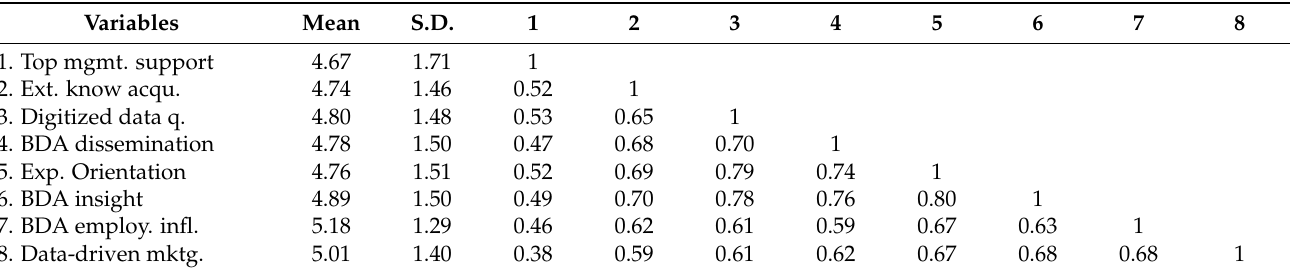
Table 2. Correlation matrix of variables.